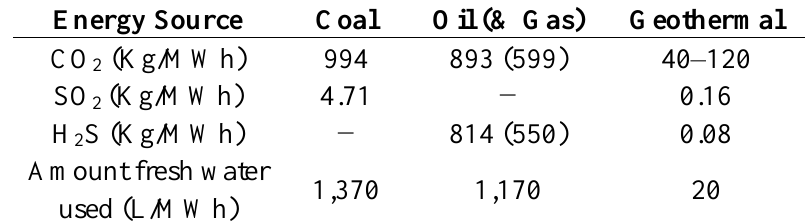
Table 2 Comparison of CO generation (MWh) from different energy sources (adapted in part from Fridleifsson, et al.